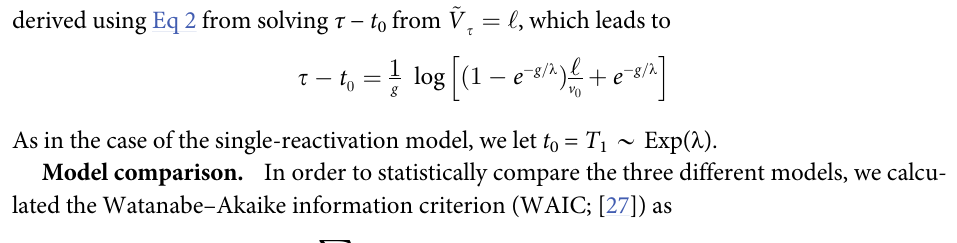
analyses can be downloaded from https://github.com/lanl/multiple-reactivation-model.